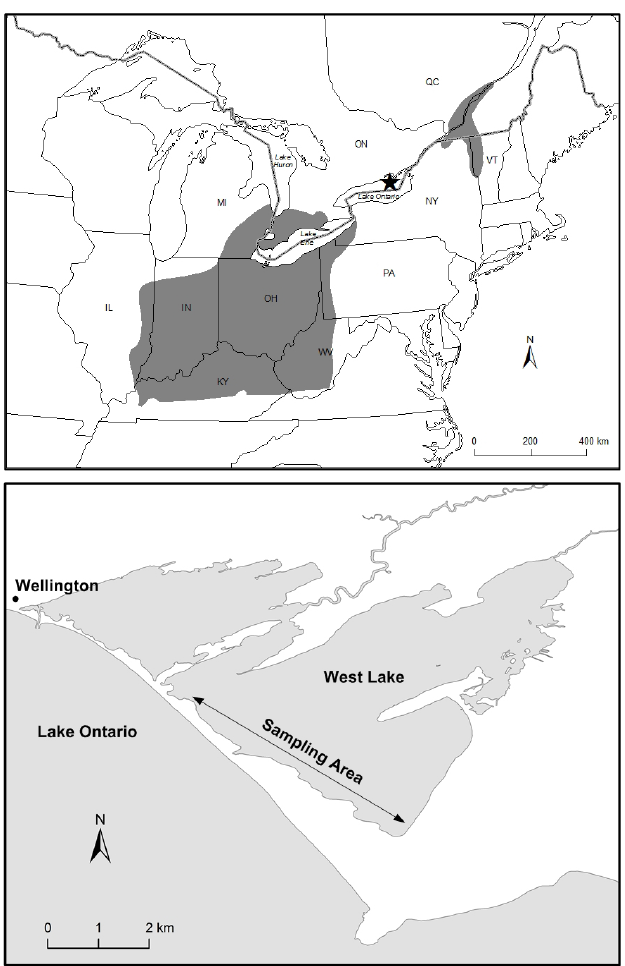
Figure 1. Global range of Eastern Sand Darter (grey shaded area; modified from Page and Burr [1991]) and location of West Lake population (black star) (upper) and sampling area within West Lake (lower).